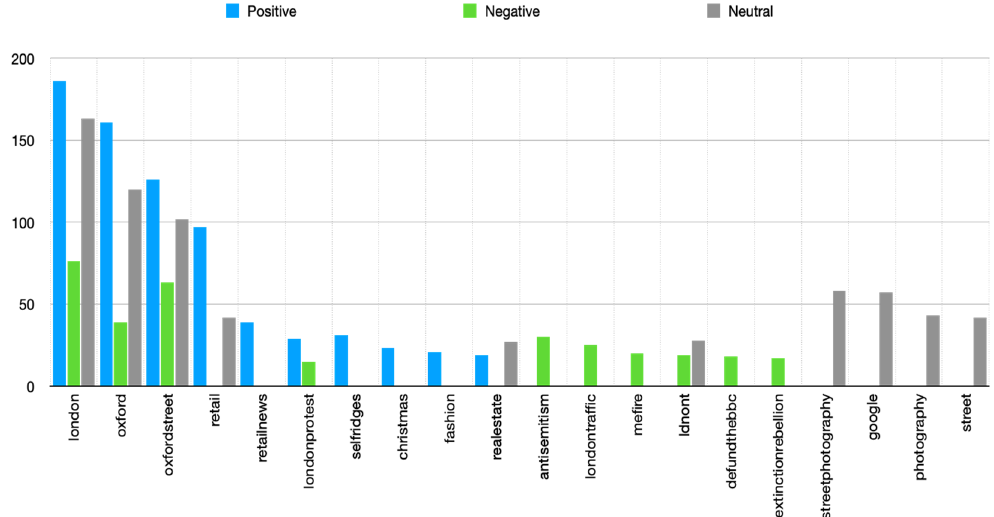
Figure 3. Number of tweets with most frequently used hashtags by positive, negative, and neutral sentiments. Table 4. Overall sentiment values for the collected data.